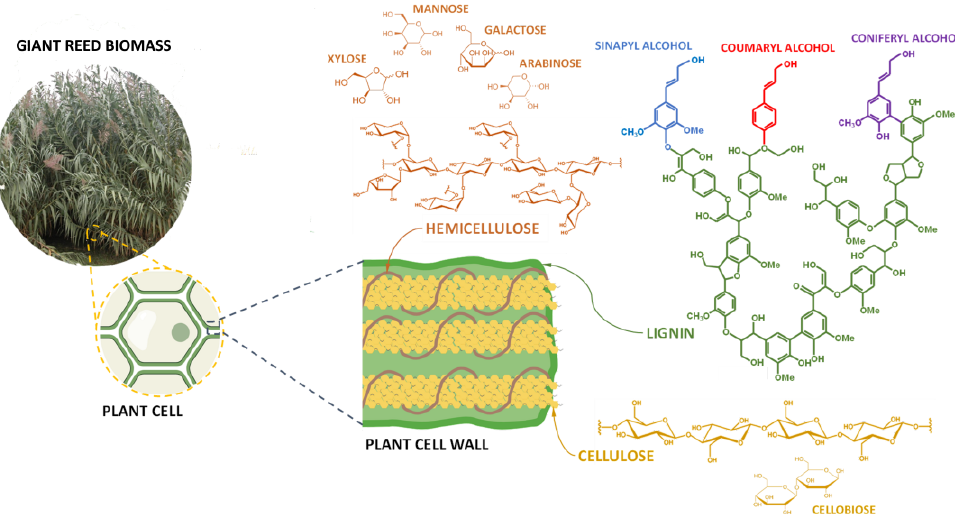
Figure 1. Lignocellulosic biomass structure (modified from [45], published under CCBY 4.0 license). Hemicellulose is formed by various polymers of pentoses and hexoses with a predominance (up to 90%) of xylan-based compounds [48,49]. Both cellulose and hemicellulose (holocellulose) can be degraded during the AD process. Lignin is an aromatic polymer formed by three phenylpropane-based units. Its mo- lecular structure is inherently highly resistant to microbial attack and oxidative stress; its high hydrophobicity also lowers its biodegradability [48]. Lignin is typically bonded to cellulose, isolating the latter from microbial activity [50], resulting in a low biogas yield. Aiming to increase the biogas yield, lignocellulosic biomass must be pre-treated to increase the holocellulose accessibility to the microbial attack. Pre-treatment is also man- datory to obtain a sugar-rich substrate suitable for DF [29]. Various pre-treatment strate- gies were proposed to modify the recalcitrant structure of lignocellulosic biomass and en- hance its digestibility for bio-methanogenesis [6,51] or bio-hydrogenesis [52]. 3. Anaerobic Digestion Process for Methane Production The anaerobic digestion process converts organic matter into methane-rich biogas. Anaerobic digestion can be divided into four steps: hydrolysis, acidogenesis, acetogenesis, and methanogenesis [53] (Figure 2). Figure 2. The anaerobic digestion process. During the hydrolysis step, the macromolecules are broken down into smaller com- pounds characterized by higher solubility (i.e., amino acids, fatty acids, monosaccharides, etc.). These molecules are converted into volatile fatty acids (VFAs), alcohols, methyla- mines, H 2 , and CO 2 in the acidogenic step. Subsequently, these compounds are converted into acetic acid, H 2 , and CO 2 during the acetogenic step. The products of the former step are converted into CH 4 and CO 2 in the methanogenesis step. During both the acidogenic and acetogenic steps, H 2 is produced as a by-product, whereas CH 4 is produced only in